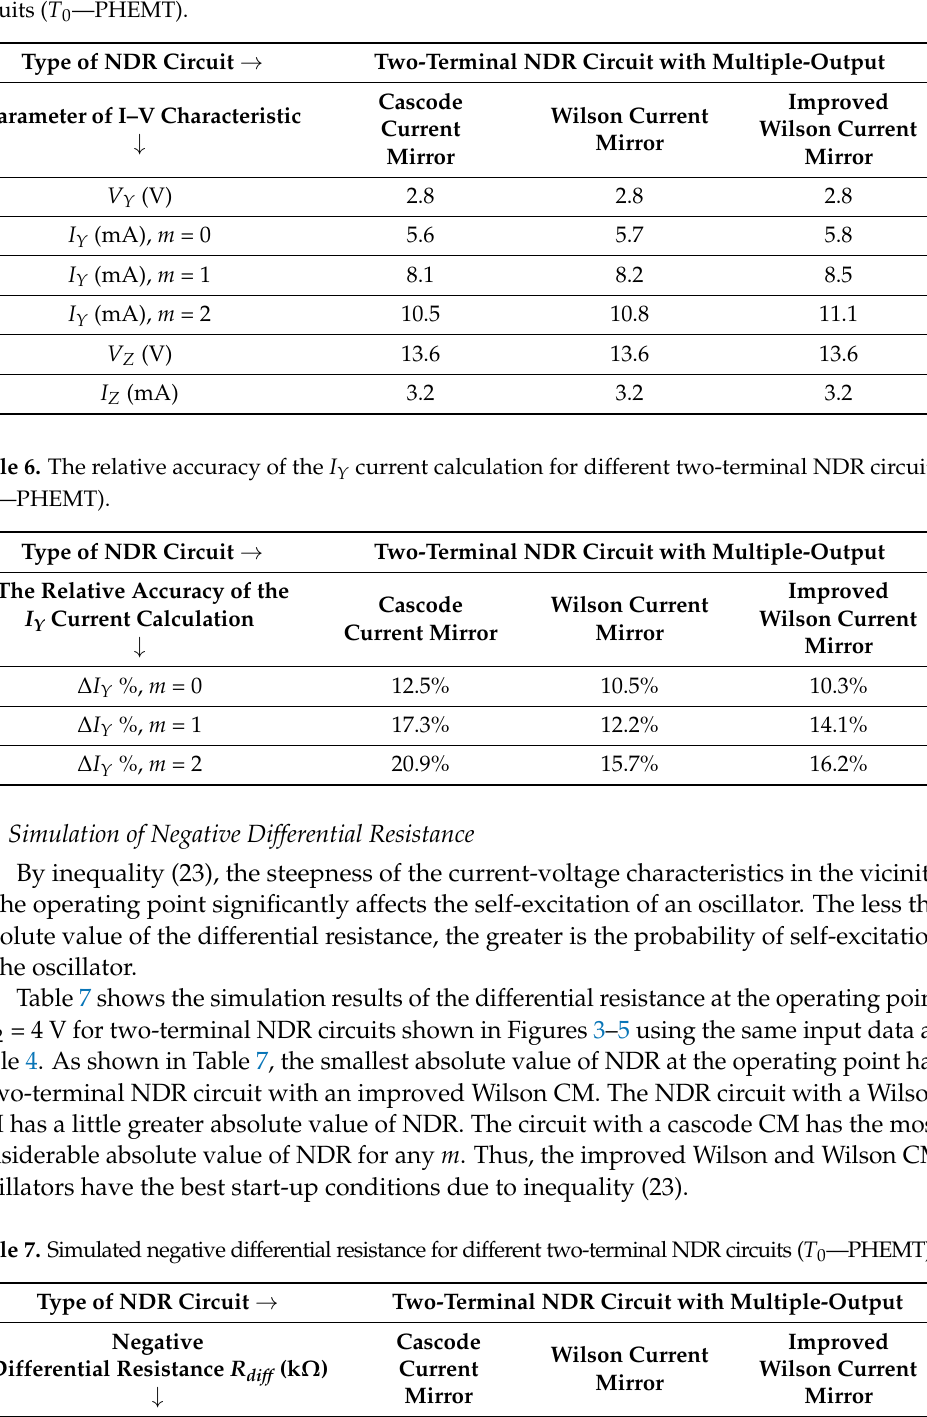
Table 5. Simulated parameters of current-voltage characteristics for different two-terminal NDR circuits ( T 0 —PHEMT).